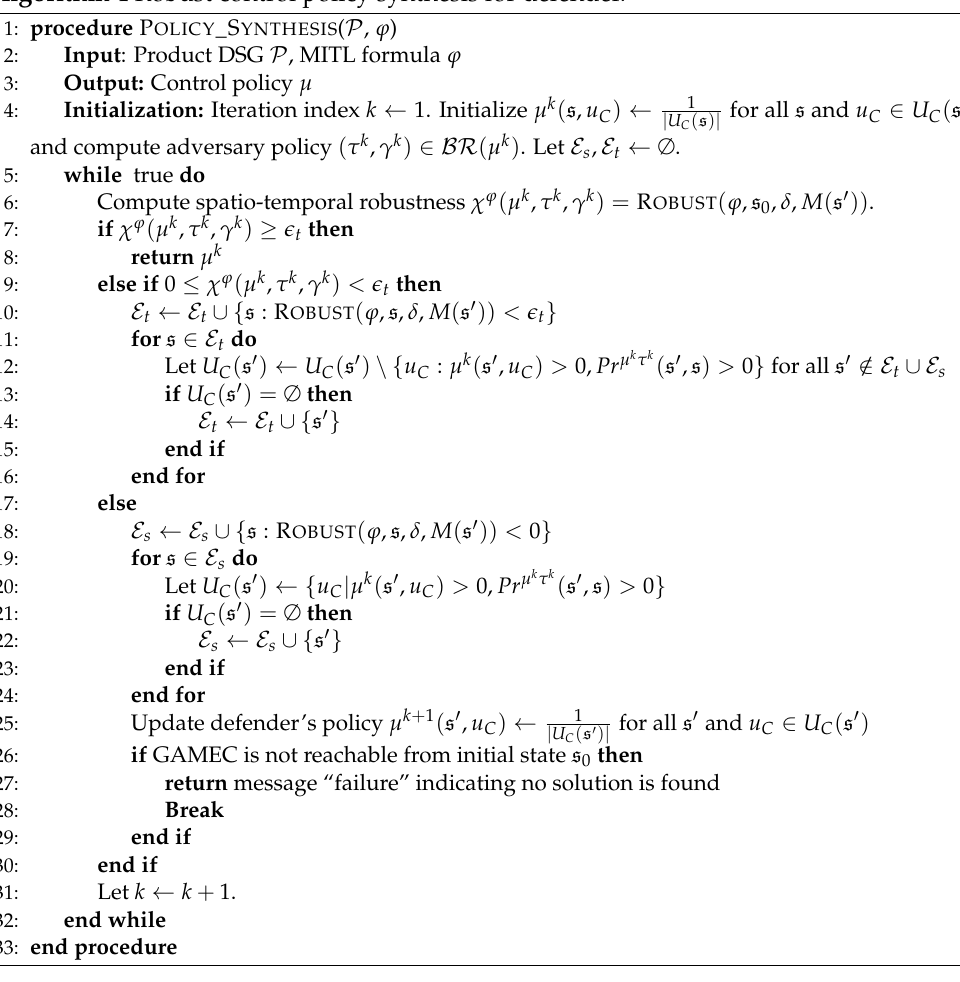
Algorithm 4 Robust control policy synthesis for